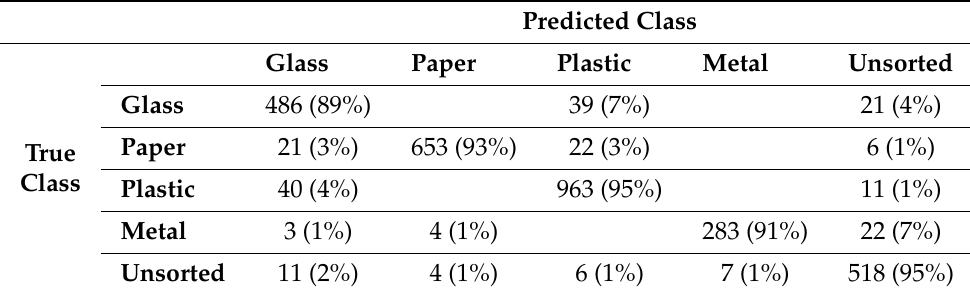
Figure 9. Material class accuracy vs. mean forward pass time. Table 4. Test confusion matrix obtained for image-based